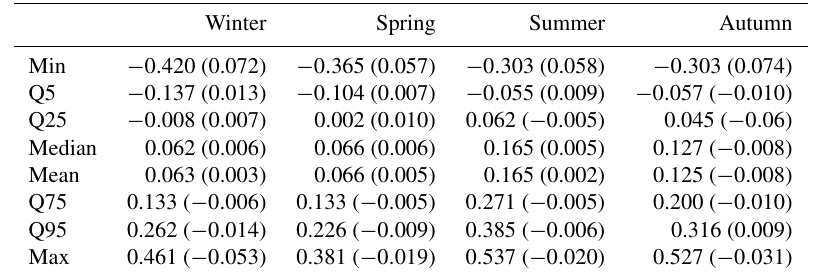
Table 4. Summary statistics of median posterior shape parameter of all stations examined. Statistics are taken over all models for one season. In the parentheses the maximum deviation of all the models fitted (classical and climate-informed) is provided.